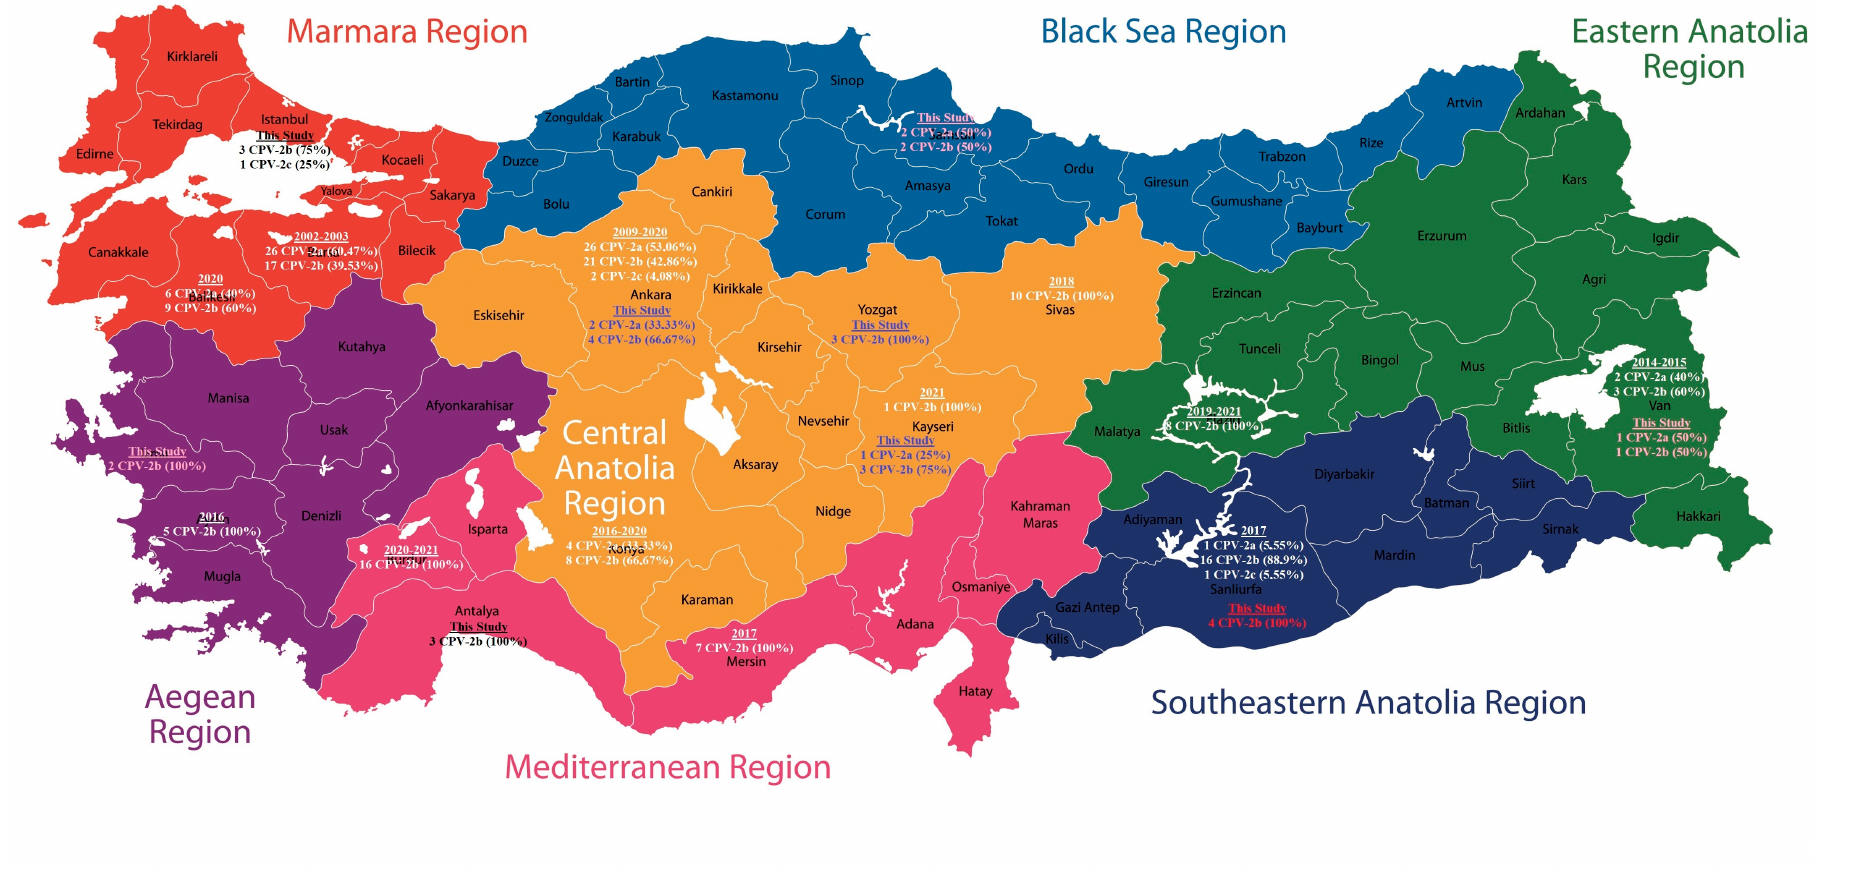
Figure 1. CPV distribution in Turkey.